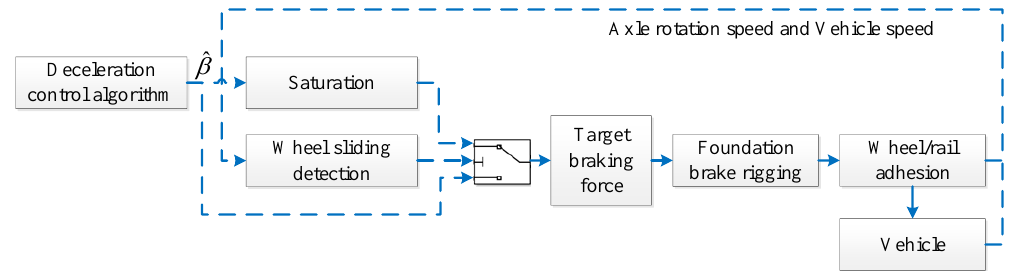
Figure 4. Schematic diagram of the compatible design.